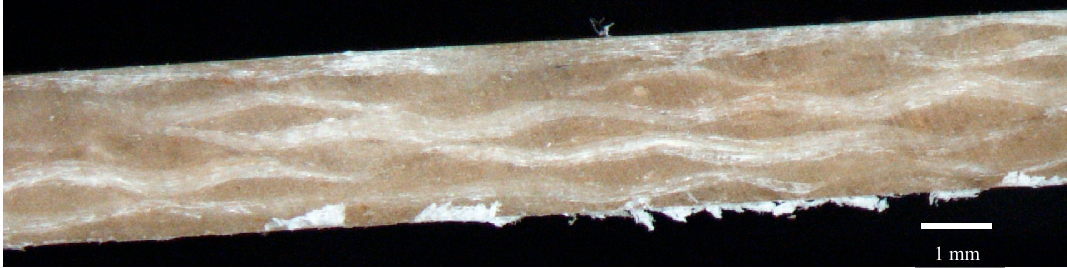
Figure 7. Microscopical picture of the Hemp-FEM composite with improved interfacial adhesion and no definite voids.